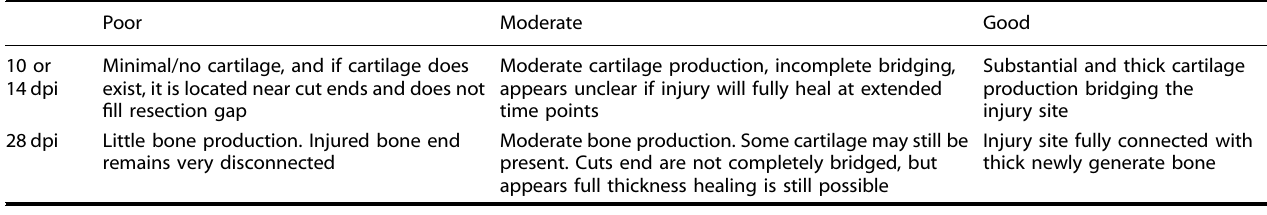
Substantial and thick cartilage production bridging the